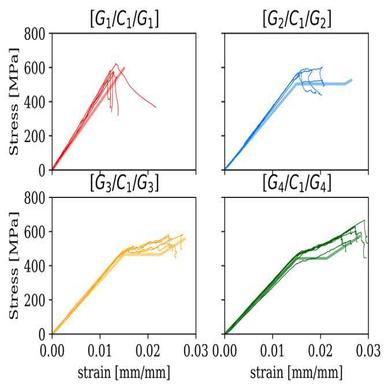
Effect of LSM thickness to full thickness ratio on the stress-strain response of hybrid 3D printed composite laminates. The bold lines represent the analytical predictions. (For interpretation of the references to colour in this figure legend, the reader is referred to the web version of this article.). (For interpretation of the references to colour in this figure legend, the reader is referred to the web version of this article.)